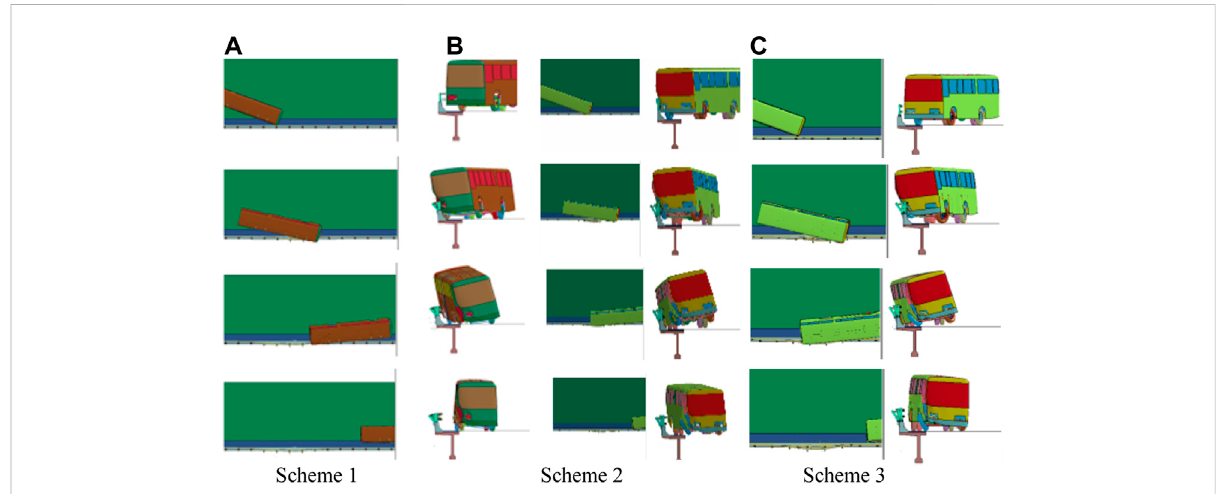
FIGURE 3 Driving process of the bus impacting the guardrail with the non-standard section. (A) Scheme 1. (B) Scheme 2. (C) Scheme 3.